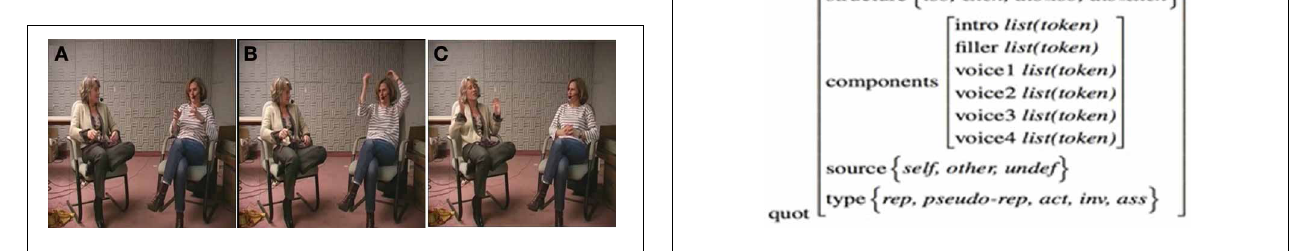
FIGURE 1 | Experimental setup for the CID. FIGURE 2 | Annotation scheme of direct reported speech in the